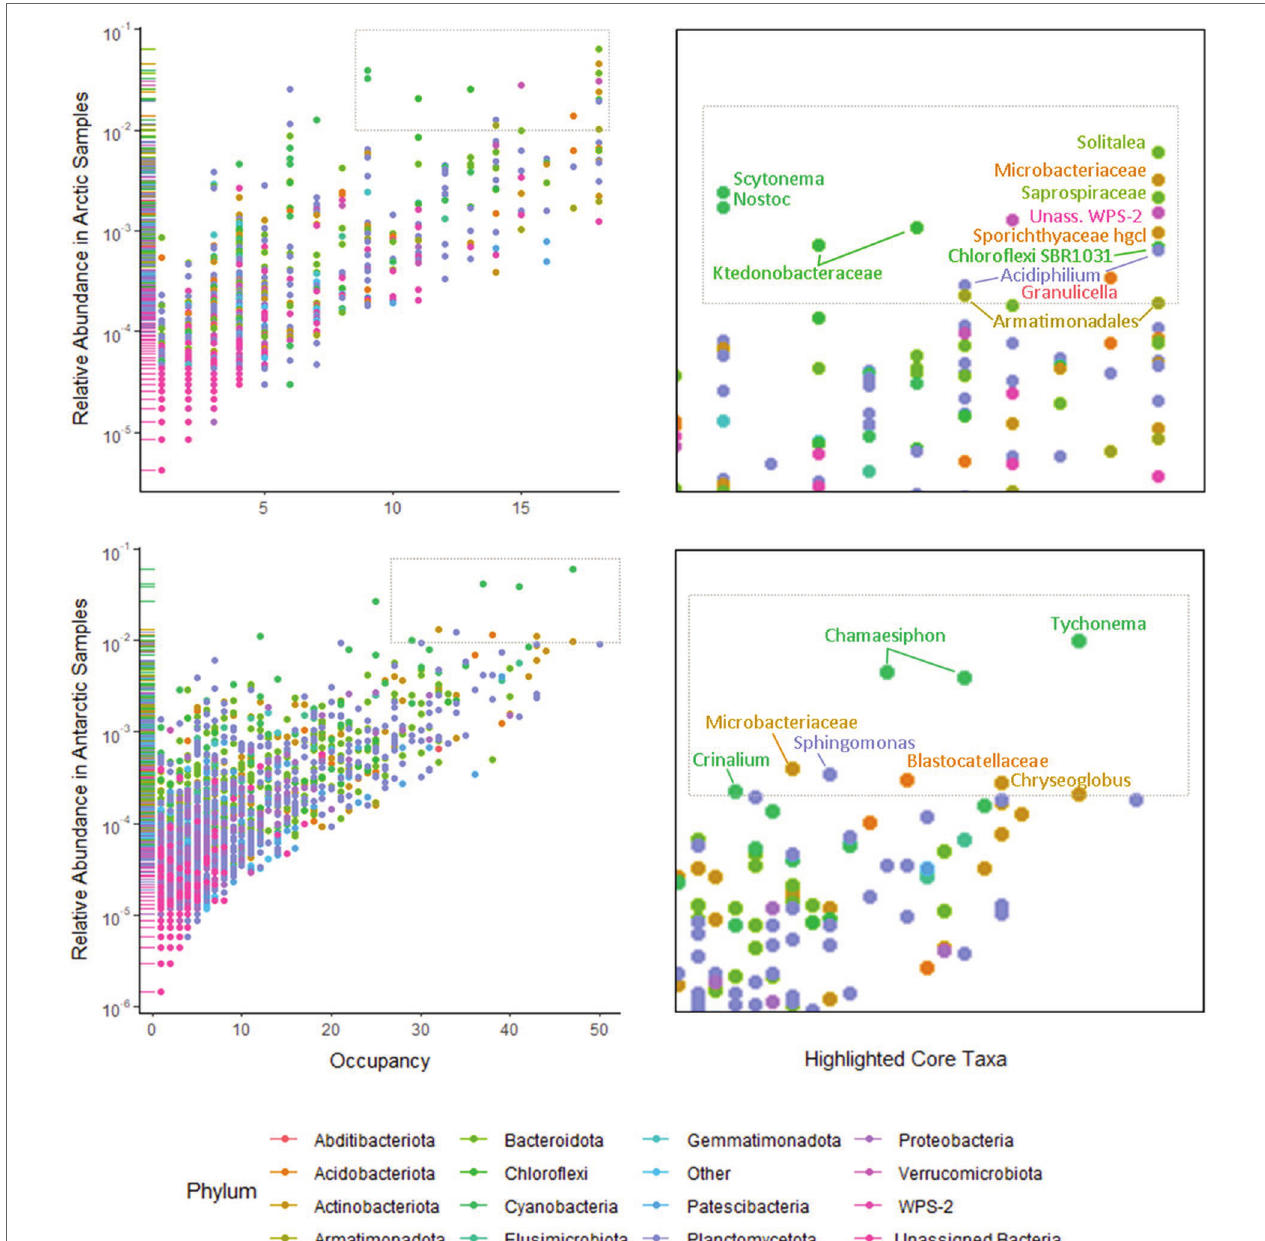
Figure 6 . Of the microbial Opisthokonts, all samples were dominated by a group of unassigned Ascomycota fungi (39% of total microbial Opisthokont sequences). Microbotryomycetes (19% of Arctic and 1% of Antarctic Opisthokonta) and Herpotrichiellaceae (12% of Arctic and 2% of Antarctic microbial microbial Opisthokonta, whereas Chytridiomycetes were more abundant in the Antarctic (19% of Antarctic sequences and